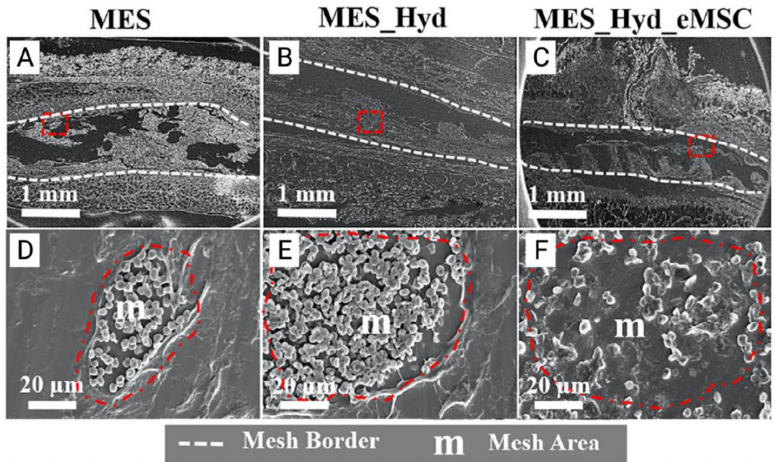
Figure 7. ( A – C ) 3D printed polycaprolactone (PCL) mesh explants visualised by electron microscopy one week after implantation. ( D – E ) Cross section of melt electrospun mesh (MES), MES_ Hydrogel and MES_Hydrogel_eMSC constructs (red dotted area) demonstrating improved integration with host tissue and neo-ECM formation ( F ). Reprinted with permission from Paul et al. (2019) [74]. Copyright Elsevier, 2019.